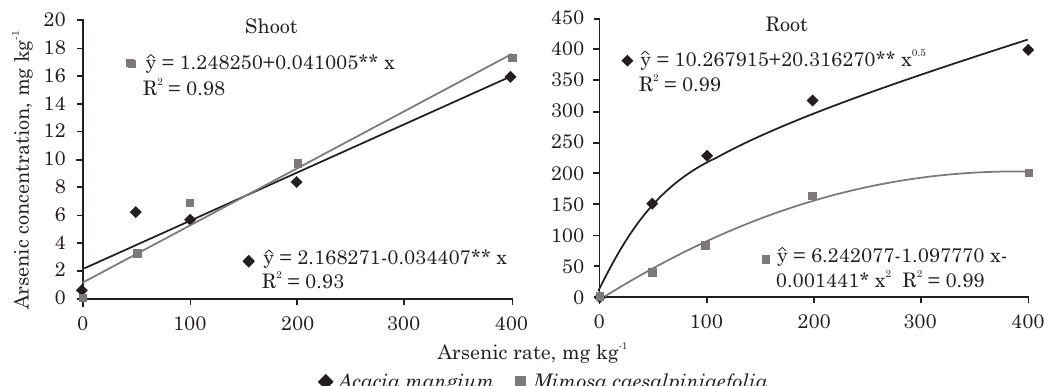
Figure 3. Arsenic concentration in the shoot (SAs) and the root (RAs) of Acacia mangium ( uuuuu ) and Mimosa caesalpiniaefolia ( nnnnn ) seedlings as a function of the As rate added to the substrate. * and ** Significant at 5 and 1 % significance, respectively.